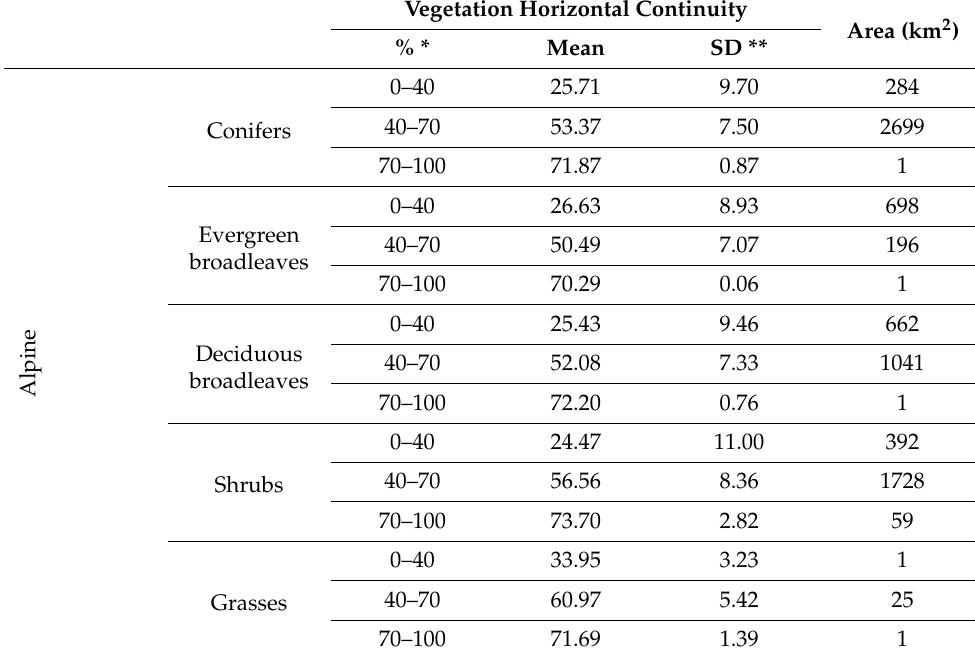
Table A3. Characteristics of the Iberian fuel